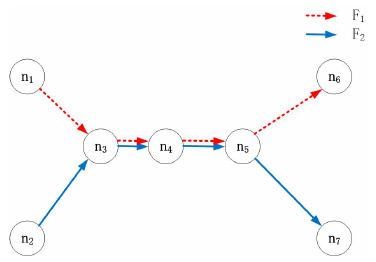
Figure 5. An example of